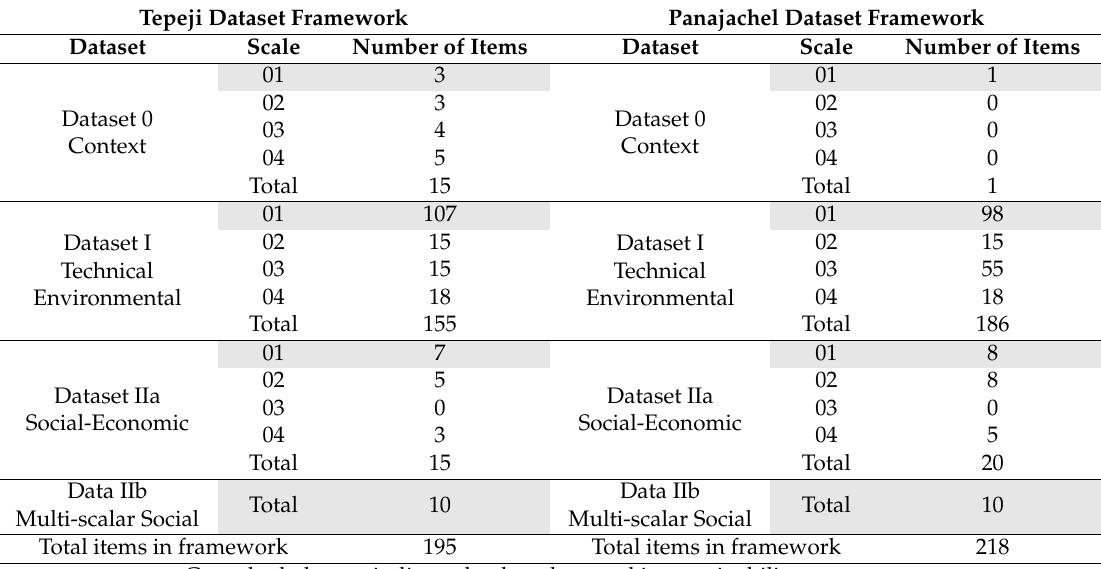
Table 5. Site-specific dataset frameworks for both pilot sites, after prioritizing the